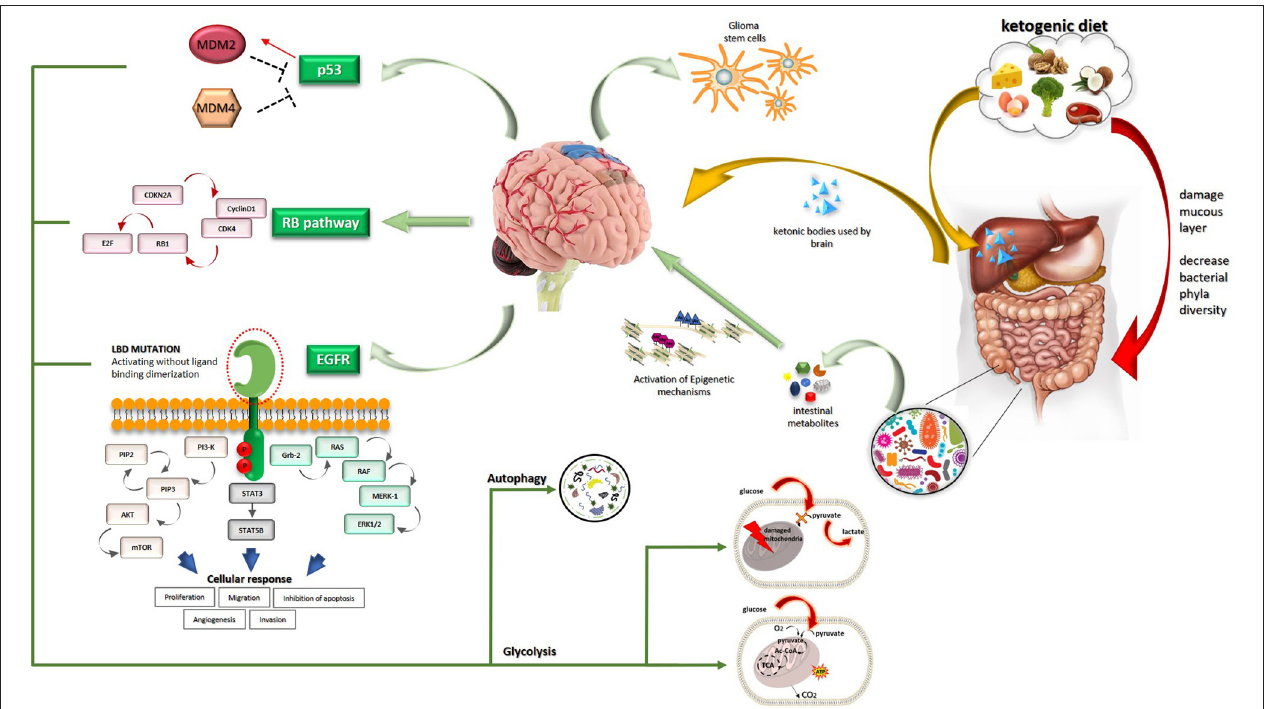
FIGURE 1 | A comprehensive view of oncogenic and metabolic pathways involved in GBM is